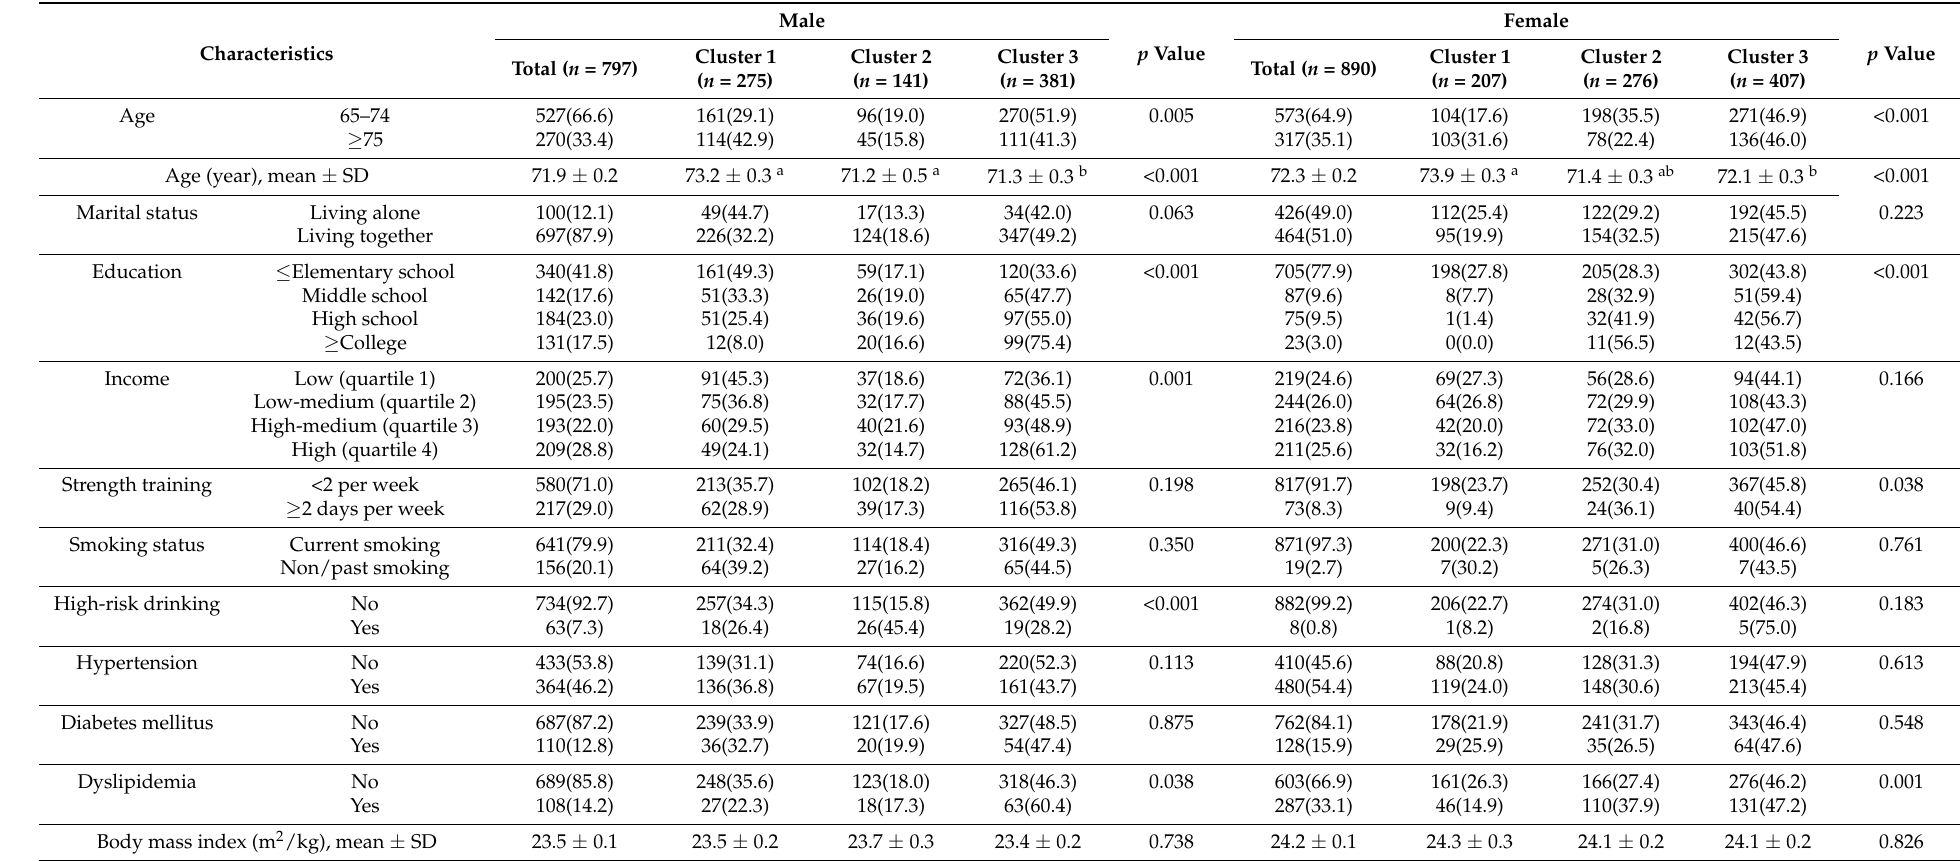
Table 1. Participant characteristics classified by dietary pattern